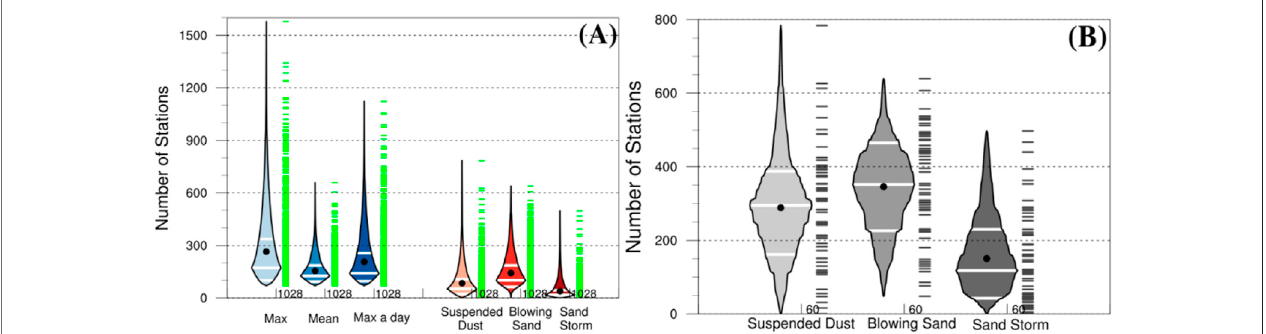
FIGURE 8 | (A) Percentile box-type diagrams of the maximum, the average number of affected stations, the maximum number of stations in a single day for all sand-dust processes, and the number of affected stations for different categories of sand-dust processes during 1961 – 2020. (B) Percentile box-type diagrams of the maximum number of affected stations for different categories of sand-dust processes during 1961 – 2020. Black dots in boxes are average values, and white lines from the bottom to the top in boxes are the fi rst, second, and third quartiles,